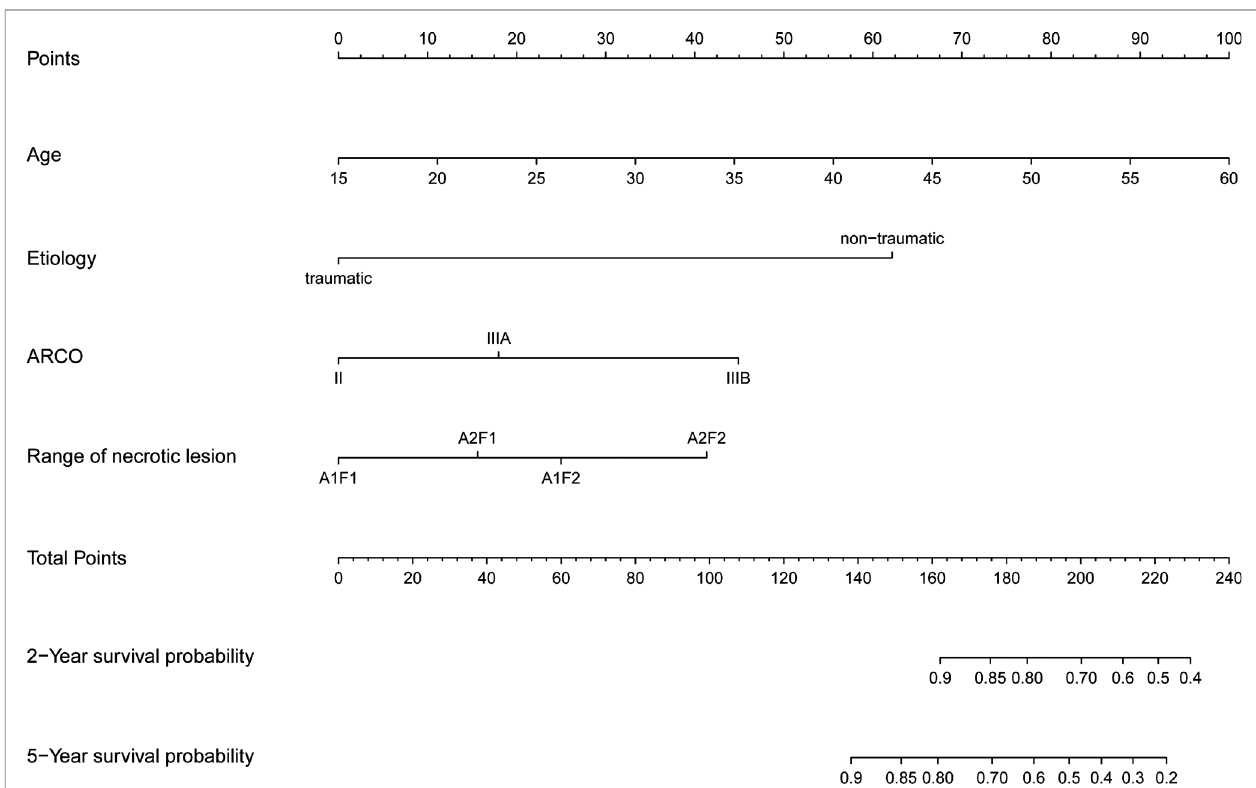
FIGURE 2 | The nomogram to predict 2-year and 5-year hip survival was established based on four independent prognostic